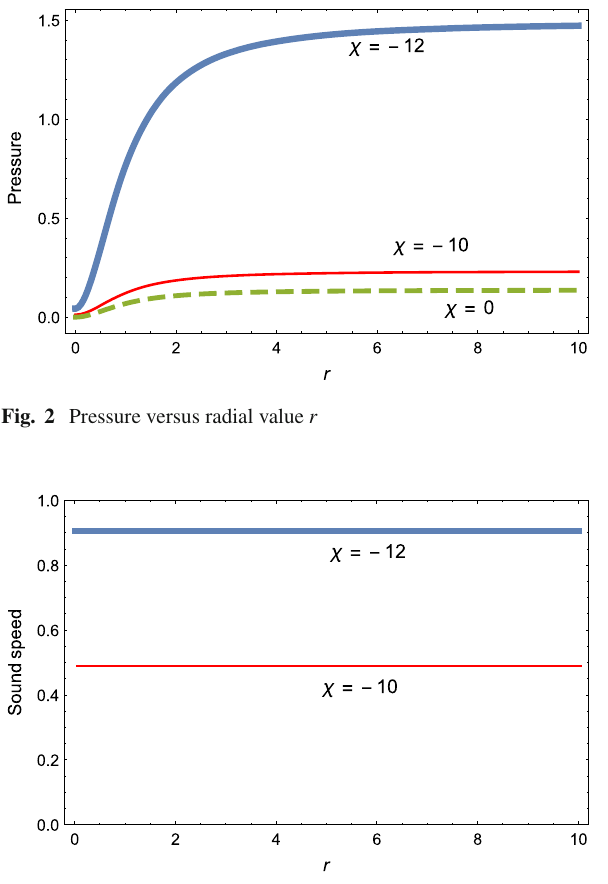
Fig. 3 Sound speed squared versus radial value